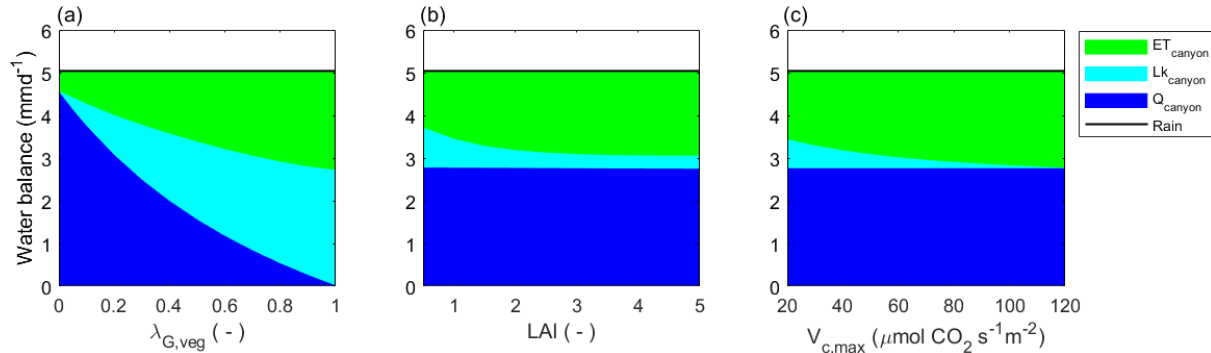
Figure 13. Water balance components in the urban canyon (ET canyon : evapotranspiration; Lk canyon : deep ground leakage; Q canyon : surface runoff) as a function of (a) vegetated ground cover fraction ( λ G,veg ), (b) leaf area index (LAI), and (c) maximum RuBisCO capacity ( V c,max ) in Telok Kurau, Singapore. The mean daily rainfall is 5mmd − 1